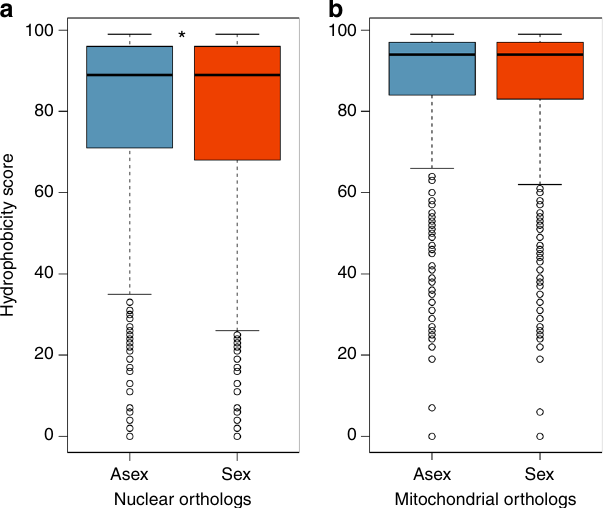
Fig. 4 Comparison of CDC values between asexual and sexual oribatid mite species. Boxplots show CDC values of three asexual (blue) and three sexual (red) oribatid mite species for ( a ) 3545 nuclear orthologous genes (involving 10,635 CDC values for both asexual and sexual species) and ( b ) ten mitochondrial orthologous genes (involving 30 CDC values for both asexual and sexual species). CDC measures the deviation of observed from expected codon usage and allows for inference of the effectiveness of purifying selection acting on synonymous sites. A lower CDC value corresponds to more ‘ relaxed ’ selection on codon usage bias (see ‘ Methods ’ ). For nuclear orthologs, per-gene CDC was slightly but signi fi cantly higher in asexual species (gene effect P < 0.001, reproductive mode effect P = 0.008, interaction P = 0.616; permutation ANOVA). For mitochondrial orthologs, per-gene CDC differed more strongly between reproductive modes (gene effect P = 0.002, reproductive mode effect P < 0.001, interaction P = 0.960; permutation ANOVA). Signi fi cant differences in CDC are marked with asterisks (*** P < 0.001 and ** P < 0.01). Whiskers correspond to 1.5 times the interquartile